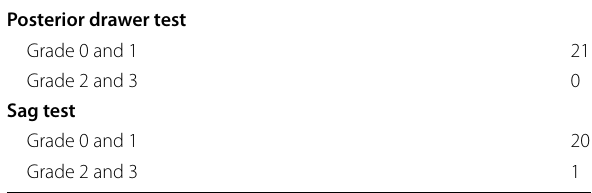
Table 7 The posterior drawer test and sag test at